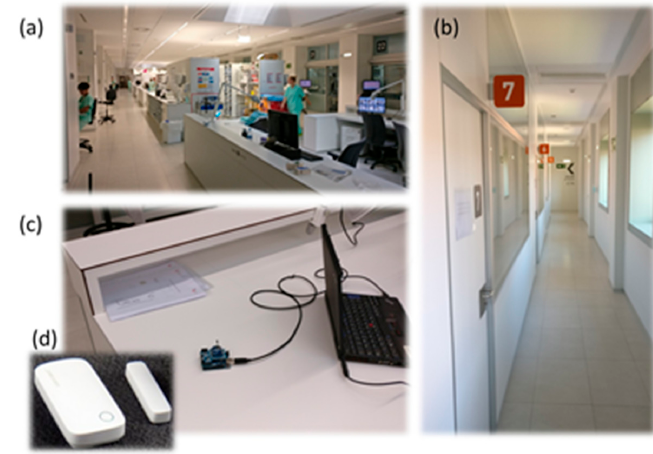
Figure 17. Working scenario: ( a ) central Zone; and ( b ) external aisles; and used wireless devices: ( c ) remote control device; and ( d ) open/close sensors.